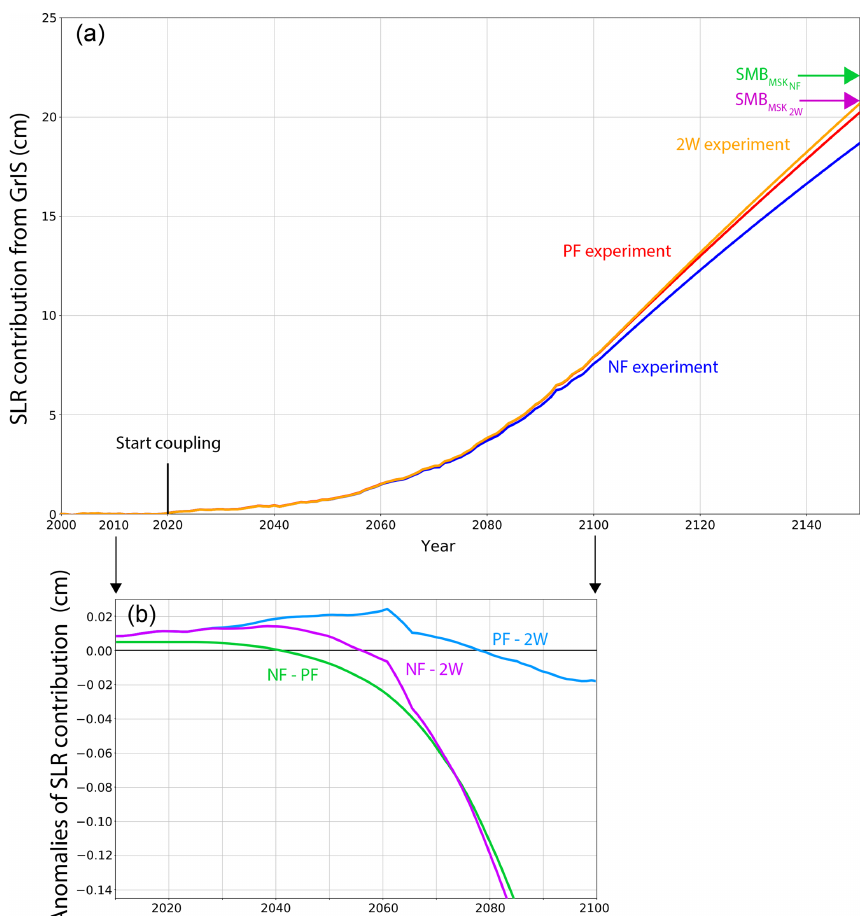
Figure 12. (a) Contribution of the GrIS to sea-level rise (in cm) as simulated in the NF (blue line), PF (red line) and 2W (orange line) exper- iments and inferred from the ice thickness changes between the 2000 and 2150. Green and purple arrows indicate the projected contribution from GrIS inferred from SMB changes integrated over the same period over a fixed ice sheet mask (SMB MSK sheet mask (SMB MSK ). (b) Zoom of the differences of GrIS contributions to sea-level rise between the NF and the PF experiments (green 2W line), between the NF and the 2W experiments (purple line) and between the PF and the 2W experiments (light blue